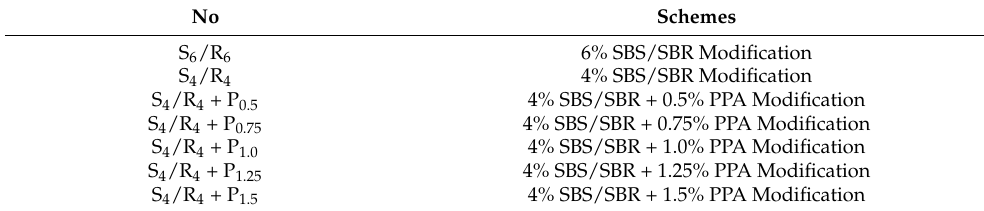
Table 3. Compound modification schemes of